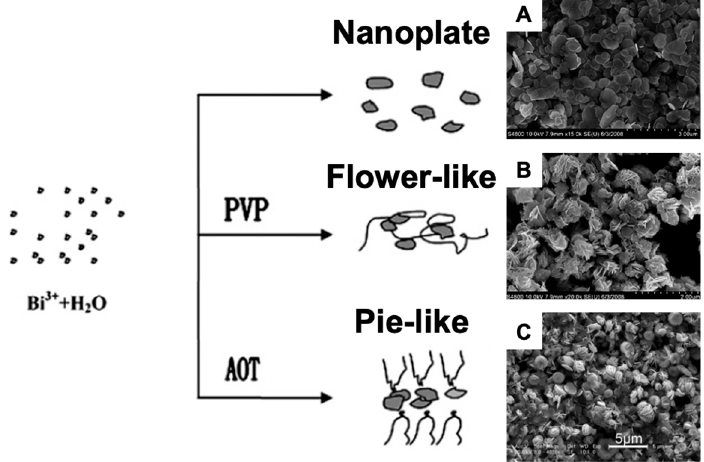
Figure 1. SEM images of BiOCl nanoplate ( A ), flower-like ( B ), and pie-like ( C ) microspheres, as well as the possible growth mechanism. Reproduced with permission from Ref. [36], 2009, Royal Society of Chemistry.